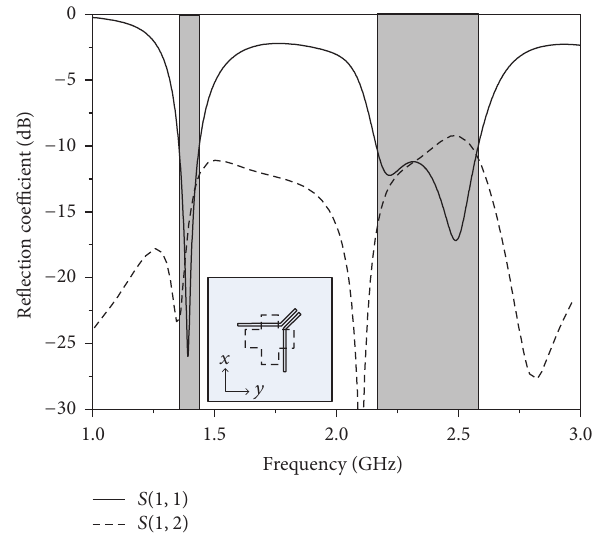
Figure 5: Simulated reflection coefficient with slots on the ground